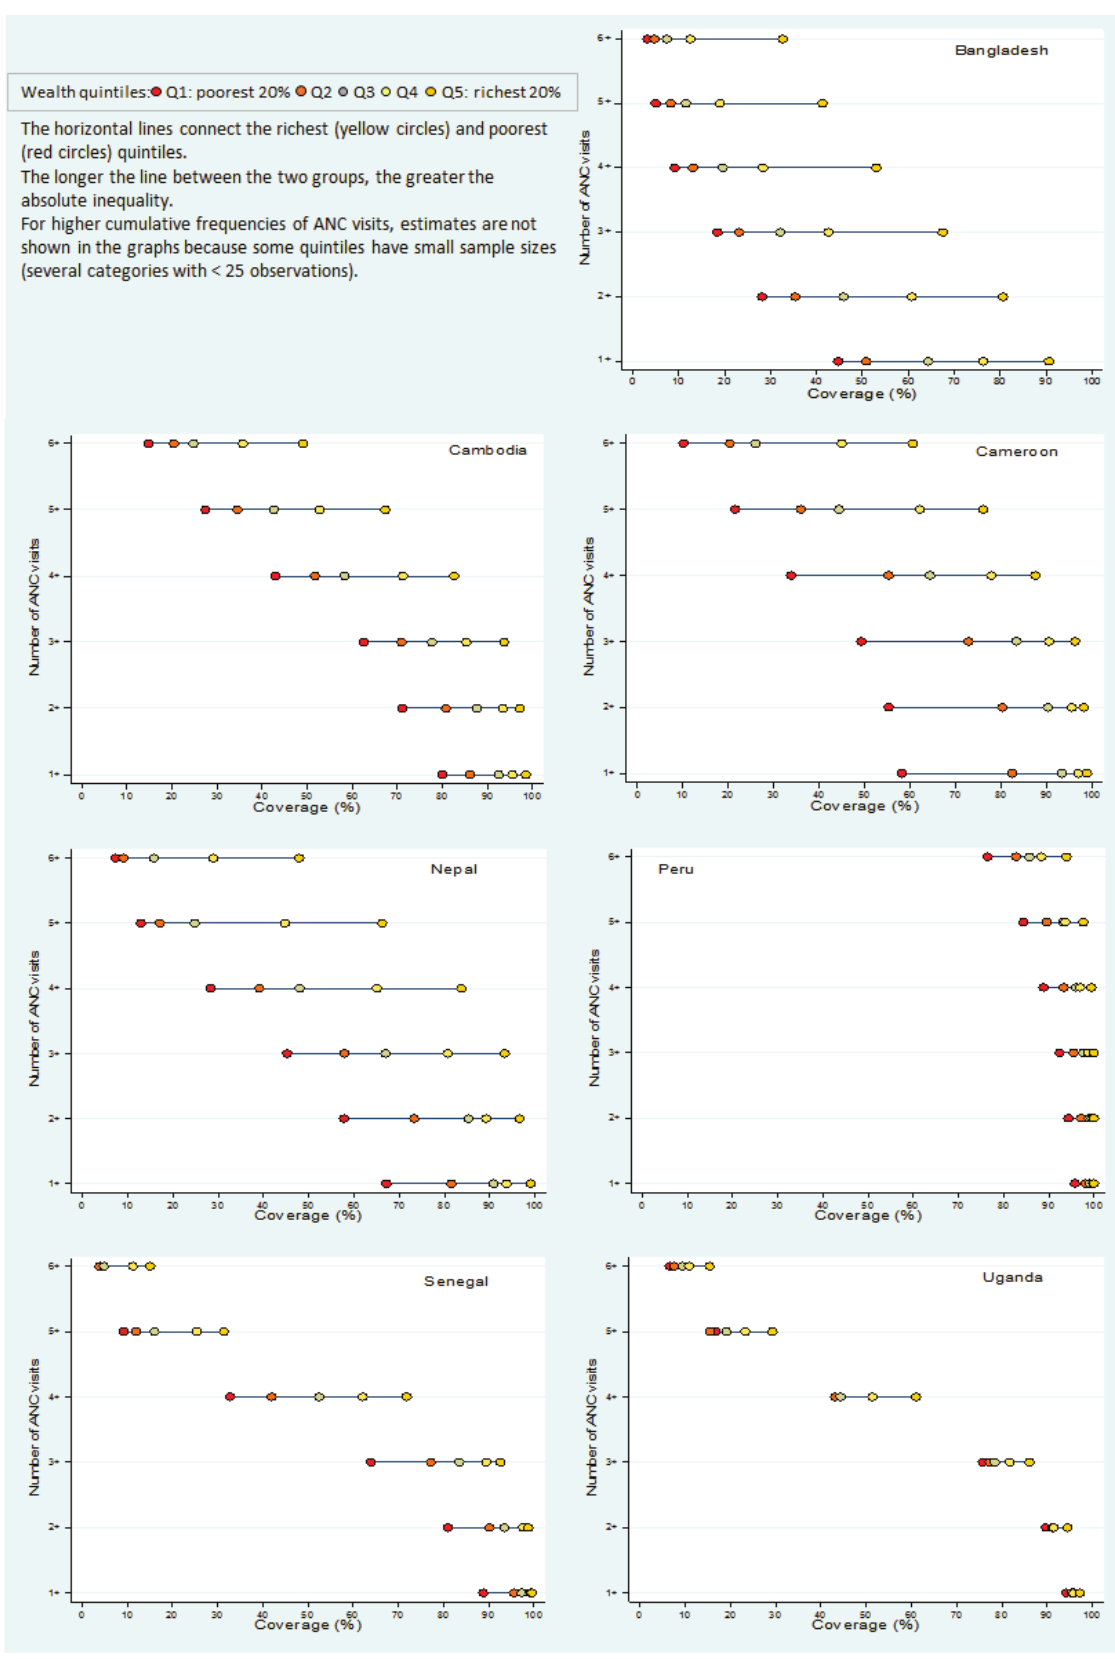
Figure 5. Percentage of women who had a live birth in the five years preceding the DHS surveys by number of ANC visits and household wealth quintiles, in seven Countdown